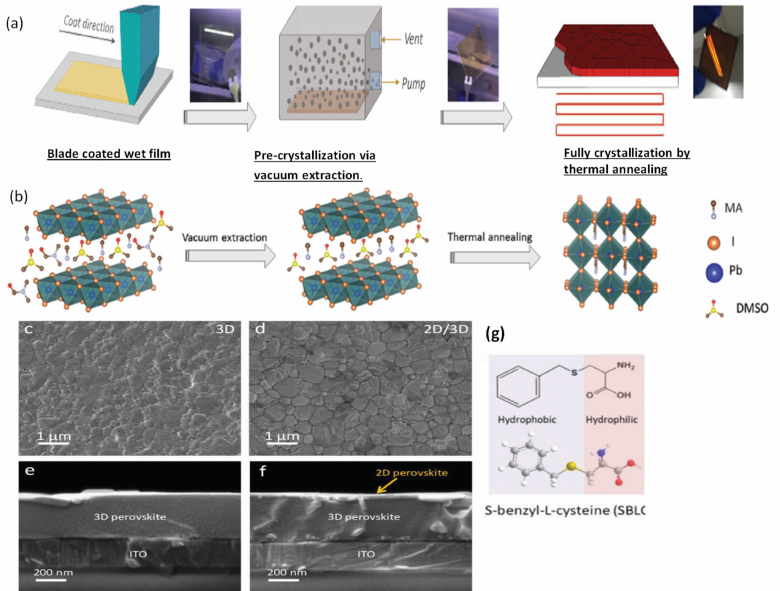
Figure 7. ( a ) Represents the one-step deposition and vacuum-assisted crystallization of a blade coated perovskite film. ( b ) Printed precursor colloids then vacuum extraction to create an intermediate film by removing solvent from printed wet film and finally the fully crystallized perovskite film after